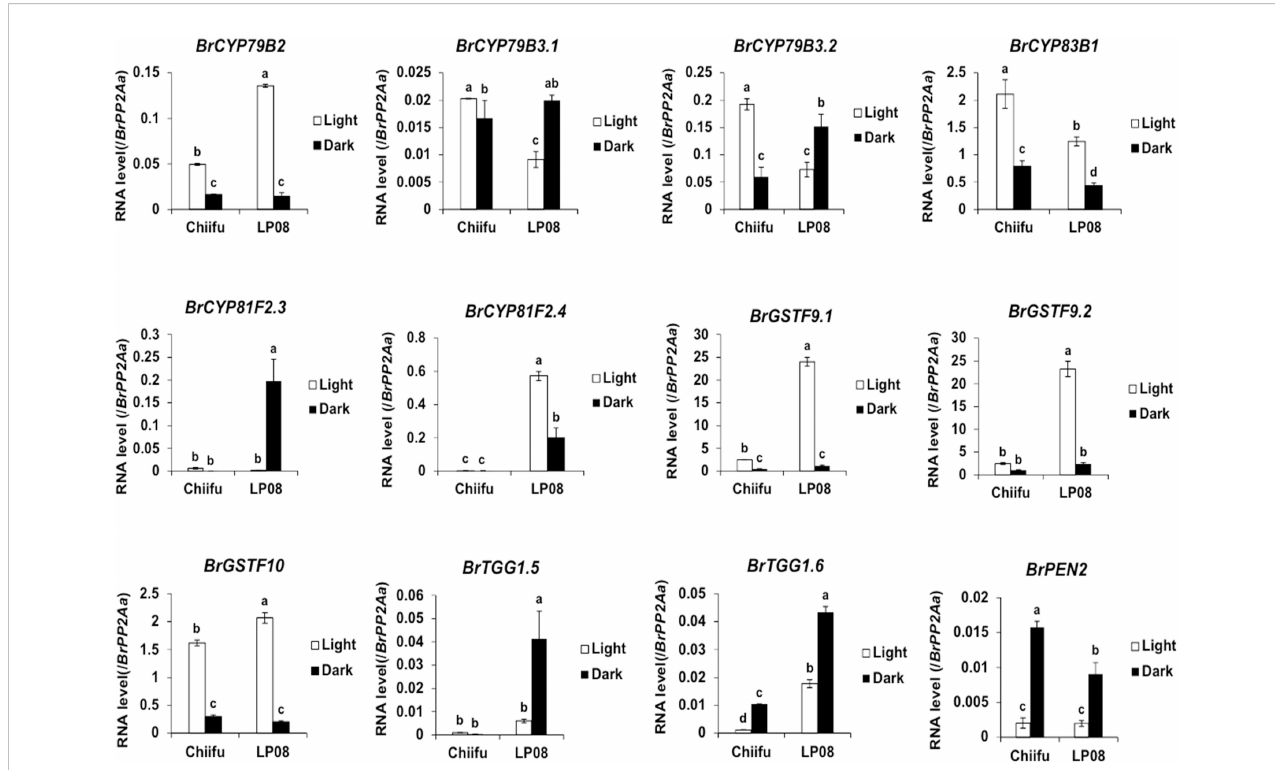
FIGURE 7 qRT-PCR analysis of 24 aliphatic GSL metabolic genes in ‘ Chiifu ’ and ‘ LP08 ’ grown under light and dark conditions. Results of qRT-PCR analysis of 12 metabolic genes involved in indolic GSL biosynthesis. White and black bars indicate the expression level of each gene under light and dark conditions, respectively. Average values and standard deviations were calculated from the Ct values of three biological replicates. Signi fi cance was statistically determined using one-way ANOVA and Tukey ’ s post-hoc test ( p < 0.05), and indicated with different letters above